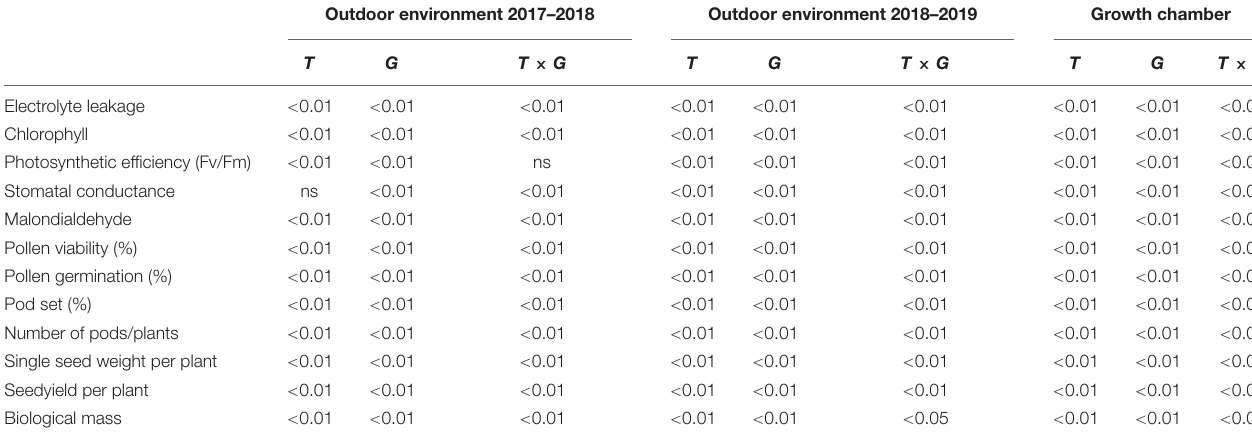
TABLE 1 | ANOVA for various traits recorded in chickpea genotypes grown outdoors in 2017–2018 and 2018–2019, and in a growth chamber under heat